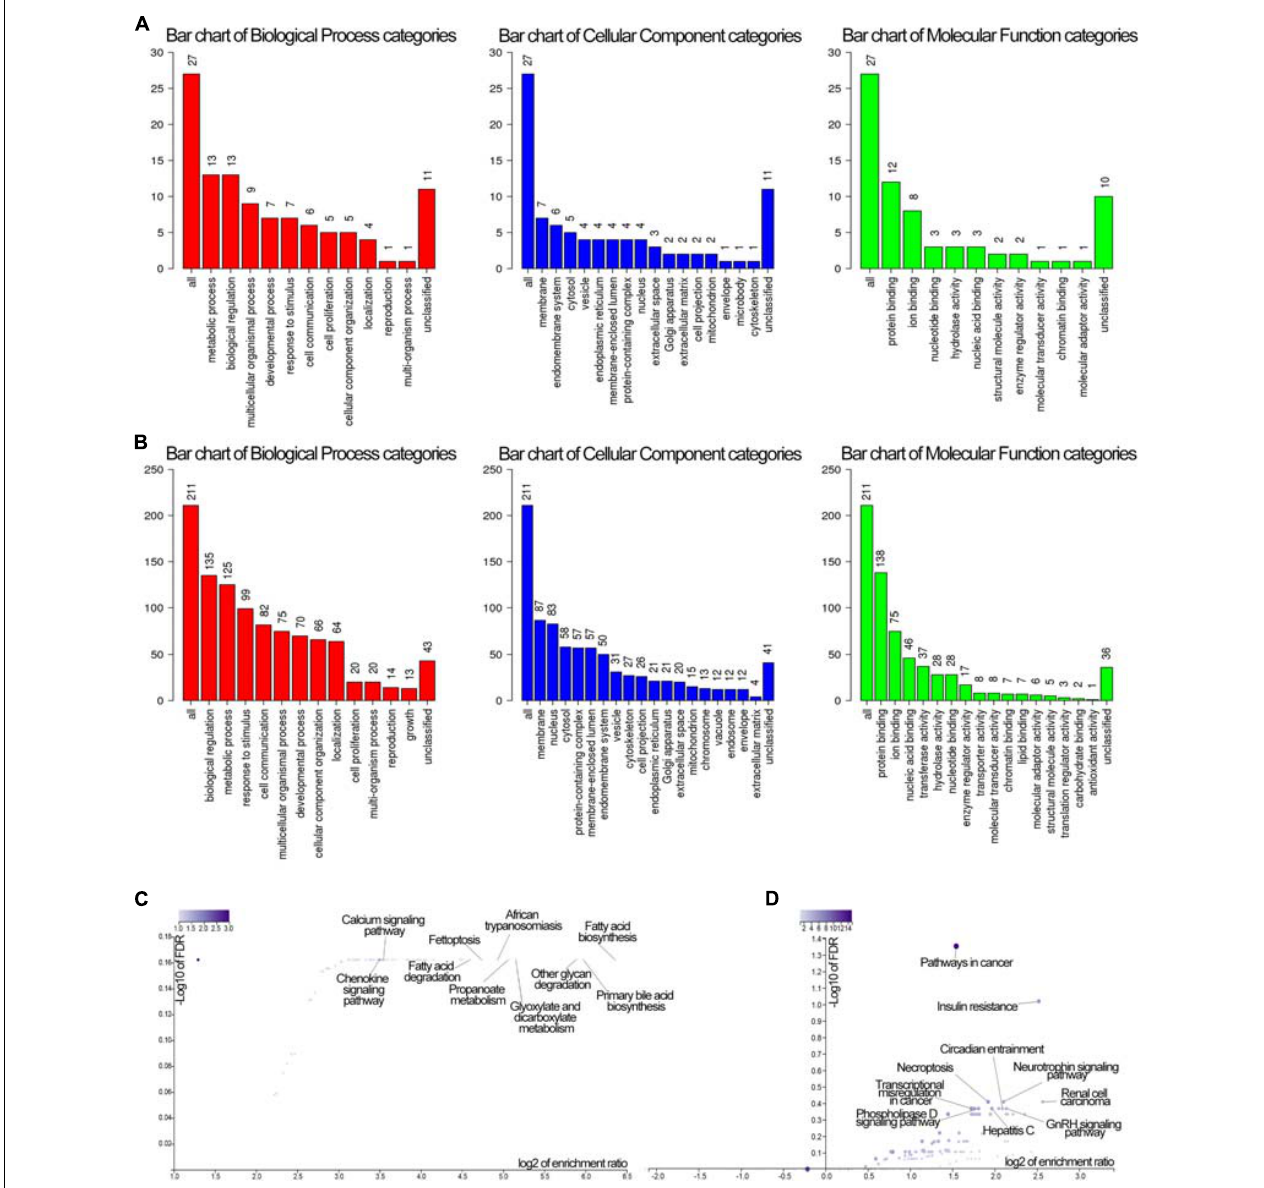
FIGURE 7 | GO and KEGG enrichment of genes in the dark green and brown modules. (A) GO enrichment of the darkgreen module. Red color stand for biological process, blue stand for cellular component, while green stand for molecular function. (B) GO enrichment of the brown module. Red color stand for biological process, blue stand for cellular component, while green stand for molecular function. (C) KEGG pathway of the dark green module. (D) KEGG pathway of the brown module. The GO enrichment vertical axis suggests the number of enriched